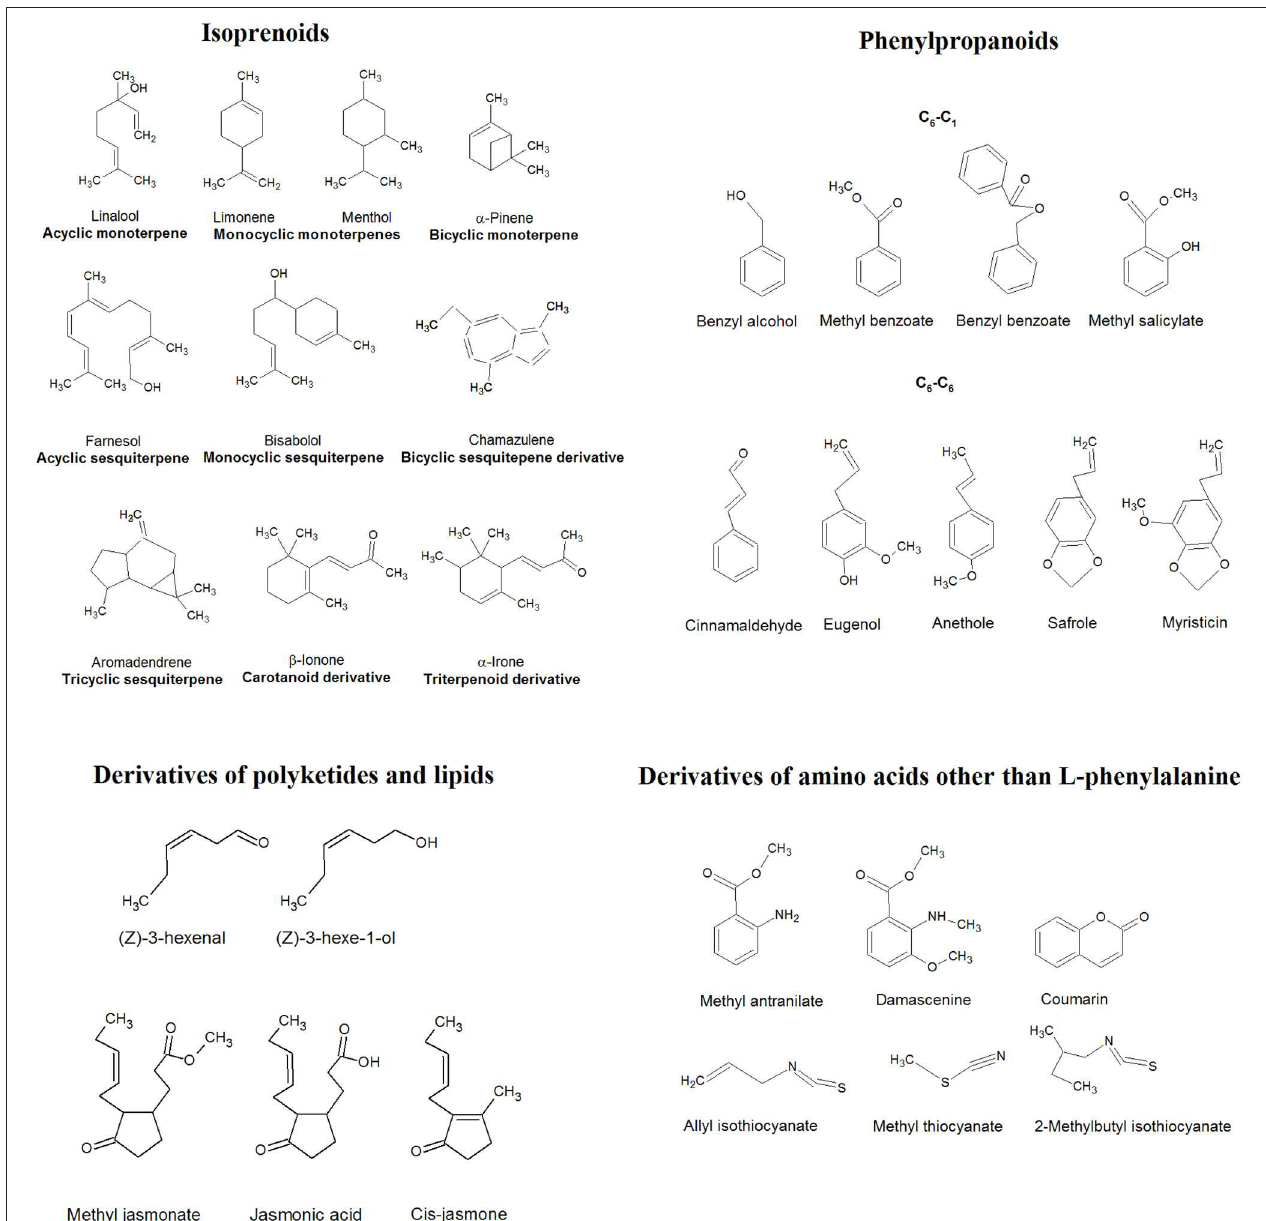
FIGURE 2 | Examples of different groups of EO